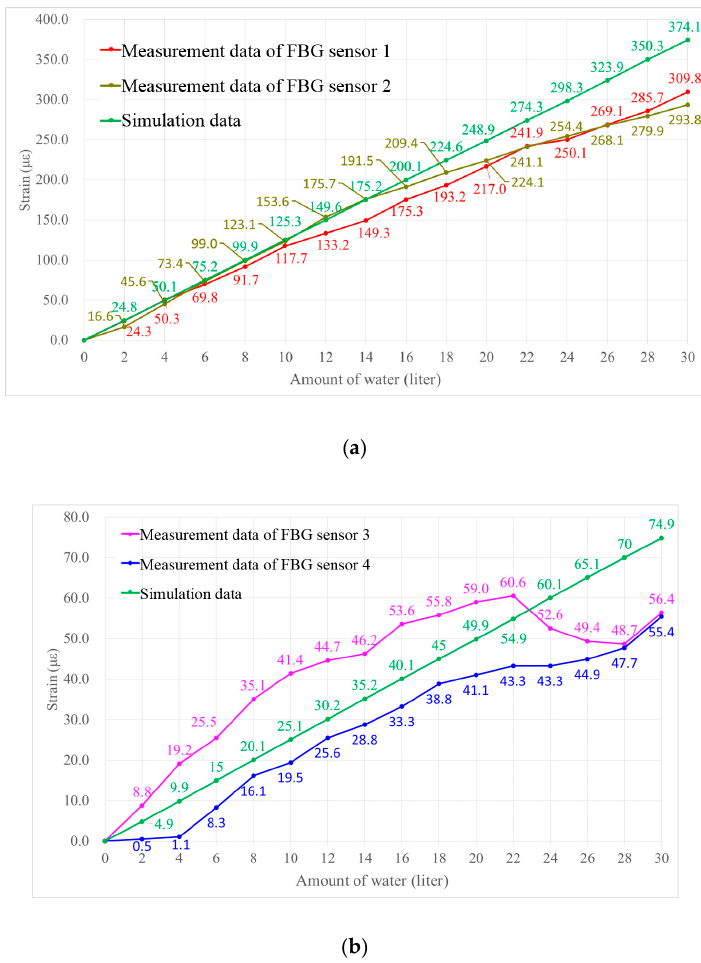
Figure 20. Comparison of measurement data and simulation data under ballast draft condition. ( a ) For sensors 1 and 2; ( b ) For sensors 3 and 4.